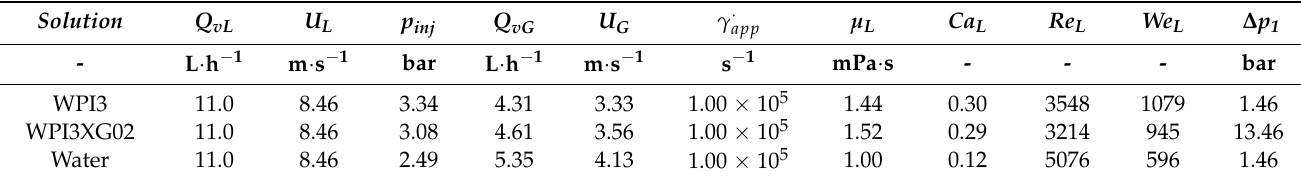
Table 6. Hydrodynamic parameters of the two-phase flow in the mixing channel of the microfluidic device CX600 for the